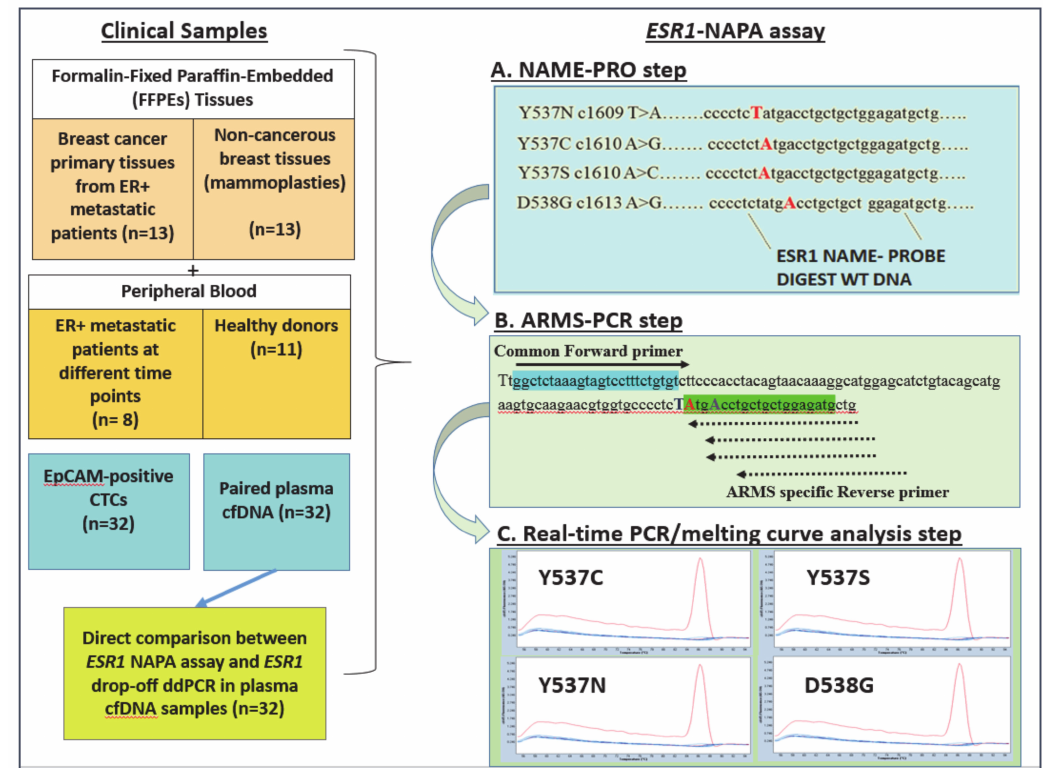
Figure 1. Outline of the experimental procedure.